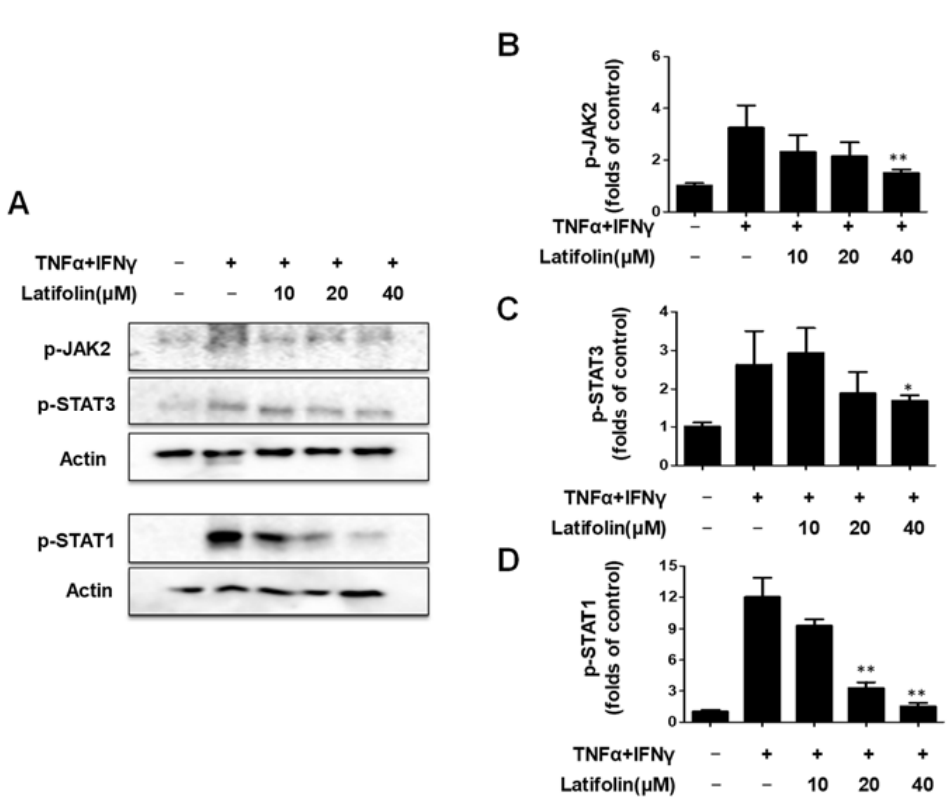
Figure 3. E ff ects of latifolin on the JAK2, STAT1, and STAT3 signaling pathways in HaCaT cells. ( A – D ). The data are represented as the mean ± SD ( n = 3). * p < 0.05, ** p < 0.01 vs. TNF- α /IFN- γ -treated group.